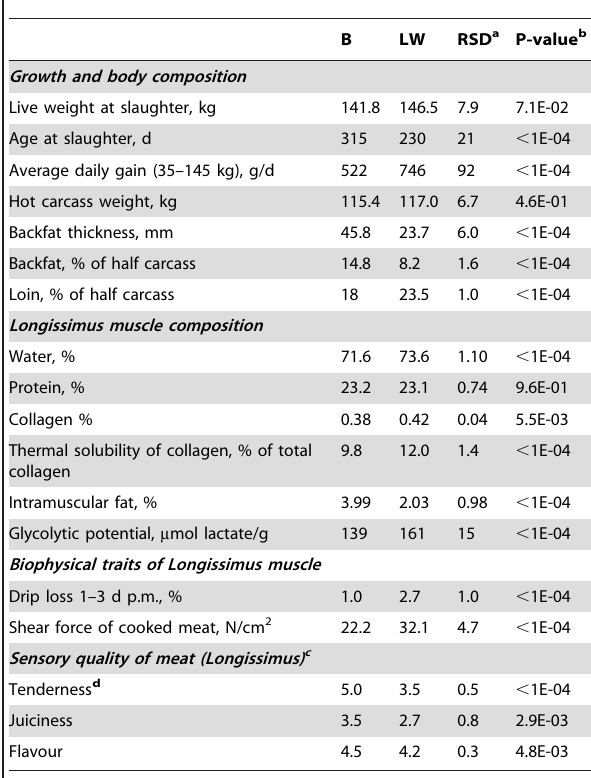
Table 1. Differences between Basque (B, n =20) and Large White (LW, n= 20) breeds for growth, body composition, and Longissimus muscle